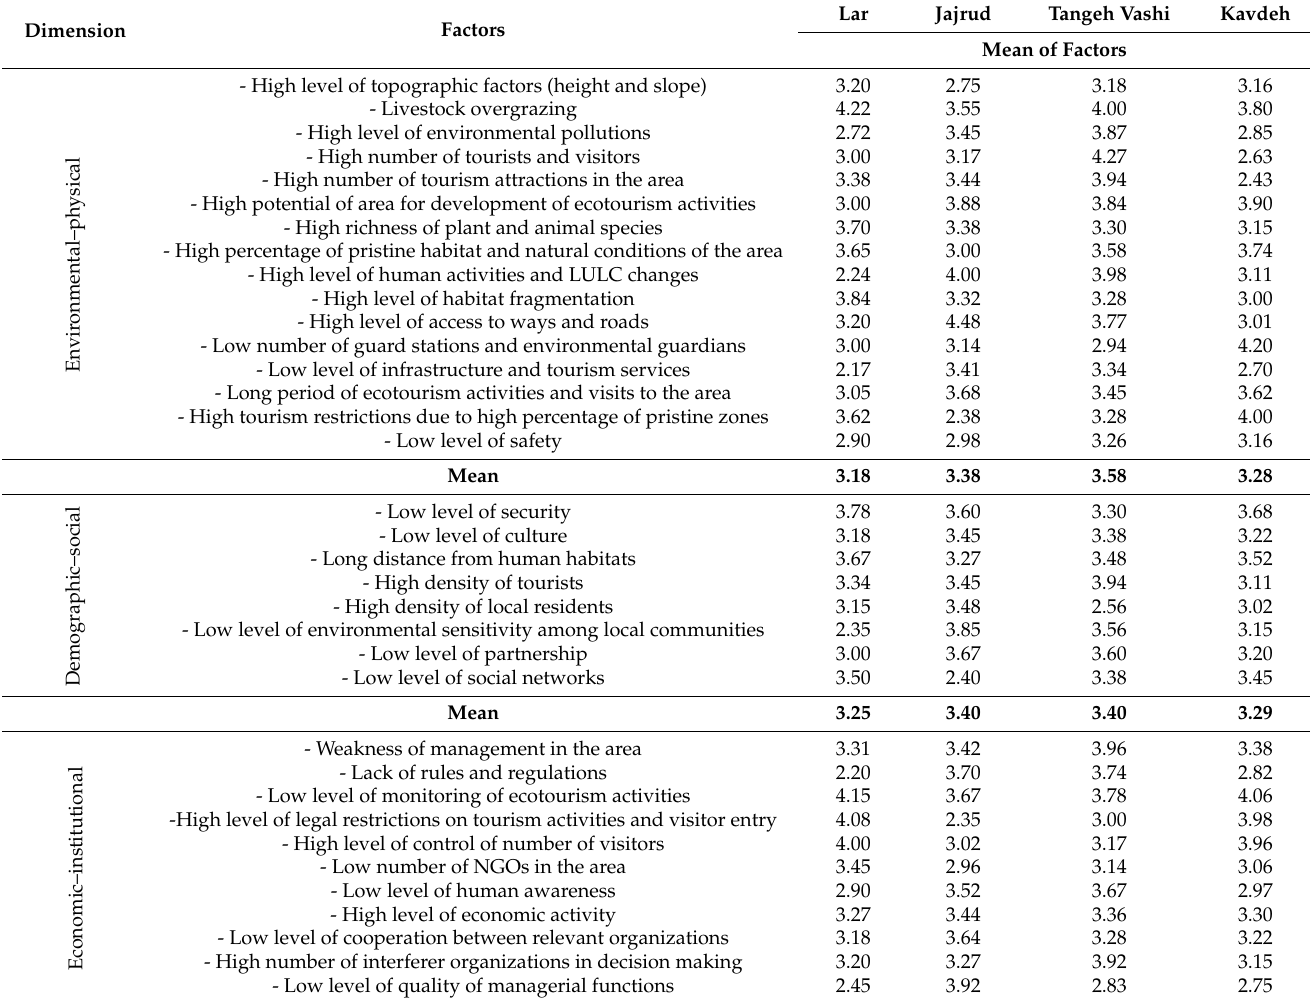
Table 7. List of factors impacting ecotourism sustainability levels in the studied areas. Dimension